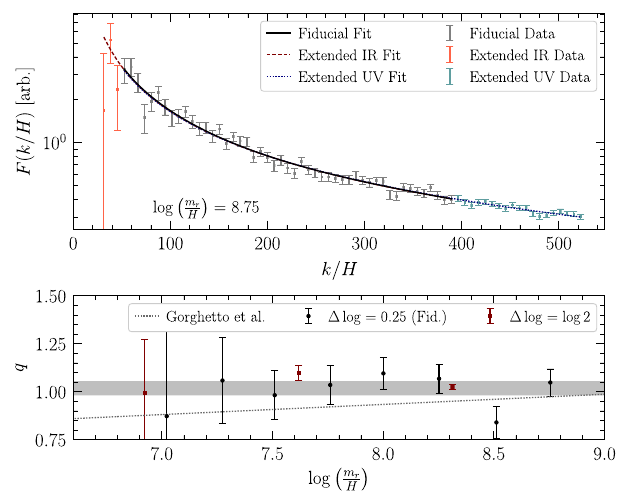
Fig. 3 The instantaneous emission spectra. (Above) Example fi ts to the instantaneous emission spectrum calculated at log m r = H ¼ 8 : 75. In our fi ducial analysis, the instantaneous emission spectra are calculated using a timestep corresponding to Δ log m r = H ¼ 0 : 25, and a power-law model is fi t to the data at k between the IR and UV cutoffs of k IR = 50 H and k UV = m r / 16. The data included in this fi t range is shown in gray with the best- fi t power law depicted in black; the indicated uncertainties are at 68% con fi dence and are derived during the fi tting procedure. We also illustrate two systematic variations, one in which we extend our IR cutoff down to k = 30 H ("Extended IR Data"), and another where we extend our UV IR cutoff upward to k UV = m r /12 ("Extended UV data"). For clarity, the data are down-binned by a factor of 2 in k / H . (Below) The evolution of the fi tted power-law index q as a function of log m r = H . The best fi t indices obtained in our fi ducial analysis are shown in black, with red showing the indices computed using Δ log m r = H ¼ log2. In our fi ducial analysis we constrain q = 1.02 ± 0.03, which is shaded. For comparison, the best fi t linear growth of q obtained in Gorghetto et al. 27 is shown in dotted